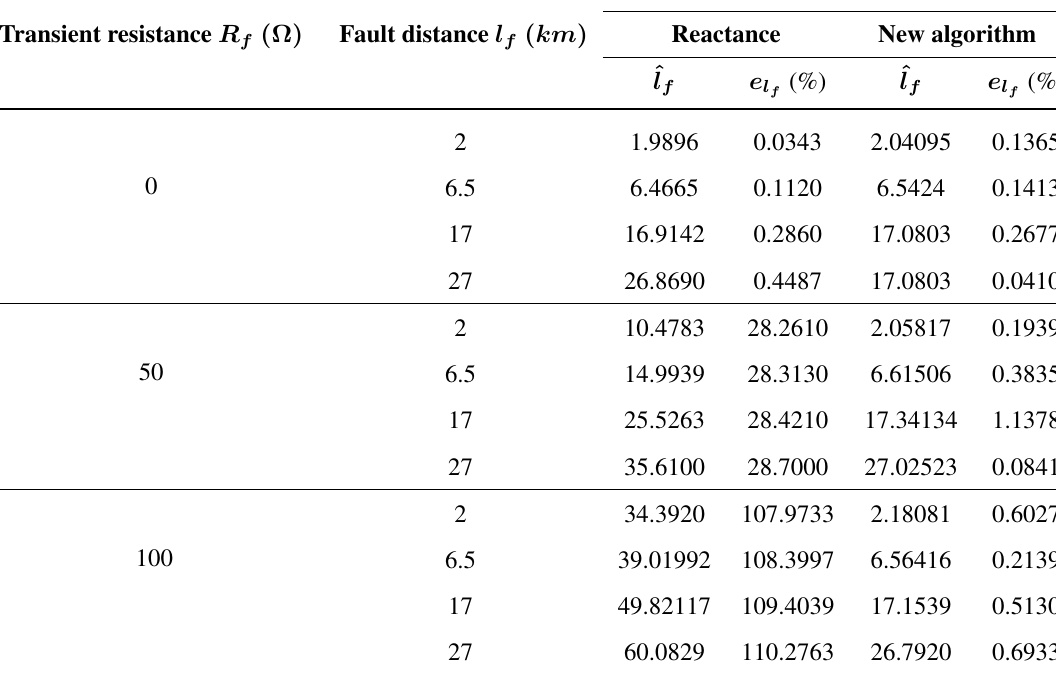
Transient resistance R f